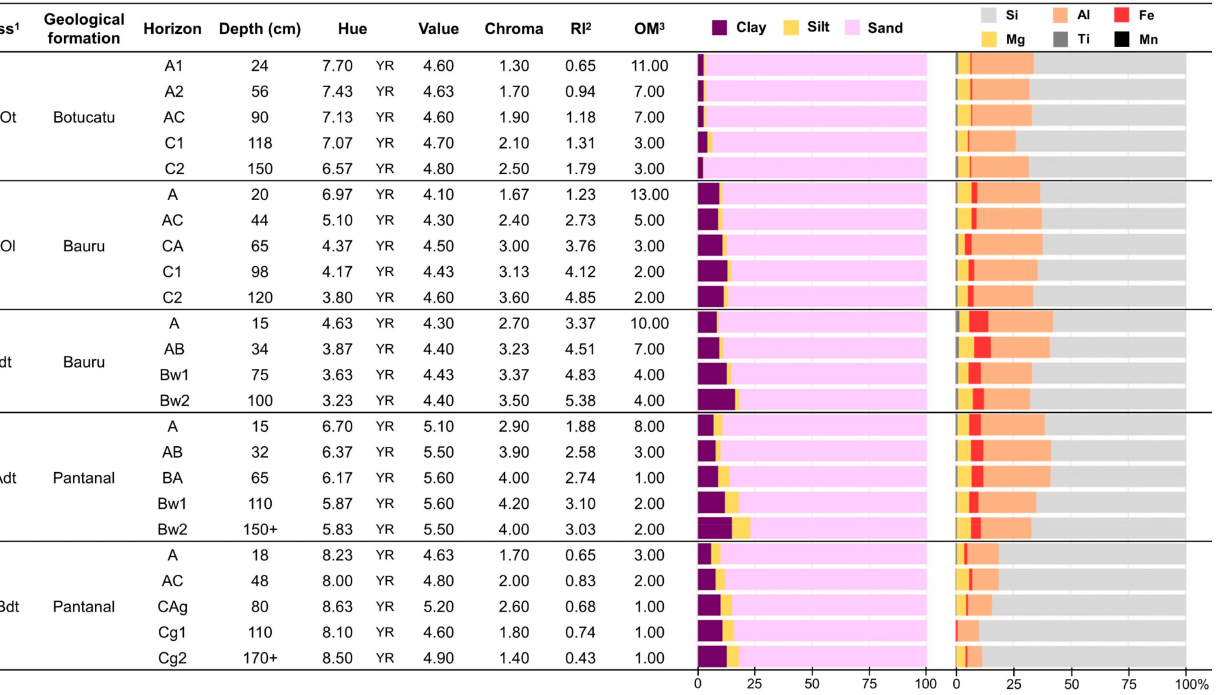
Figure 2. Attributes from the soil horizons of the different pedological classes identified ( 1 Soil class according to SiBCS: RQOt, Neossolo Quartzar ê nico Ó rtico t í pico; RQOl, Neossolo Quartzar ê nico Ó rtico latoss ó lico; LVdt, Latossolo Vermelho Distr ó fico t í pico; LVAdt, Latossolo Vermelho Amarelo Distr ó fico t í pico; and GXBdt, Gleissolo H á plico Tb Distr ó fico t í pico; 2 RI, redness index; 3 OM, organic matter, in g dm − 3